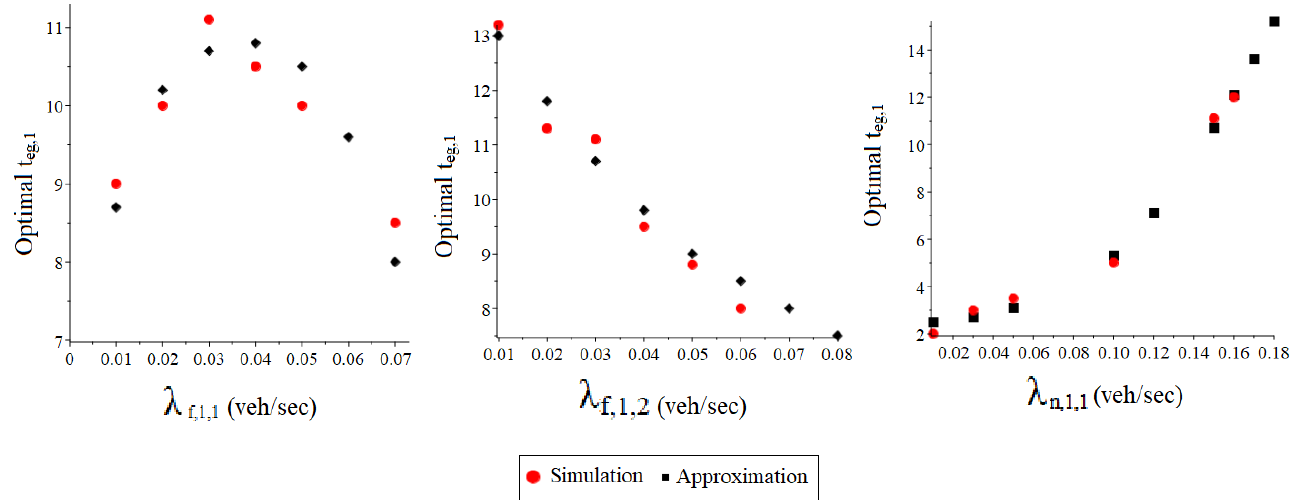
Figure 10. Comparing the optimal t eg ,1 obtained by our analysis with the results of